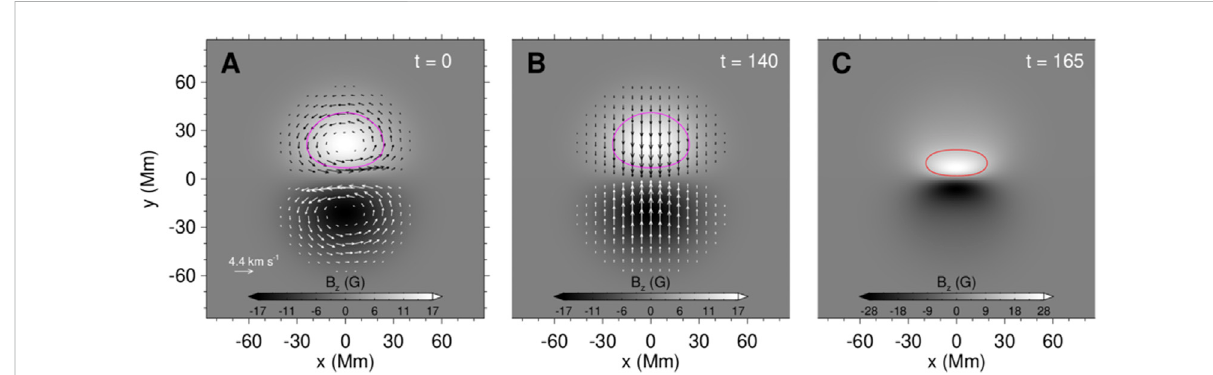
FIGURE 1 Magnetic fl uxandvelocityofthebottomsurfaceduringthesimulation. (A) Magnetic fl uxdistributionandinitialsurfacerotational(shearing) fl ow (shownbythearrows)atthebottomsurface(i.e., z =0). (B) Sameas (A) ,buttheconverging fl owstartsat t =140. (C) Magnetic fl uxdistributionattime t=165.Themagentaandredlinesrepresentthecontoursofonehalfofthemaximumofmagneticnormalcomponent(i.e., 1